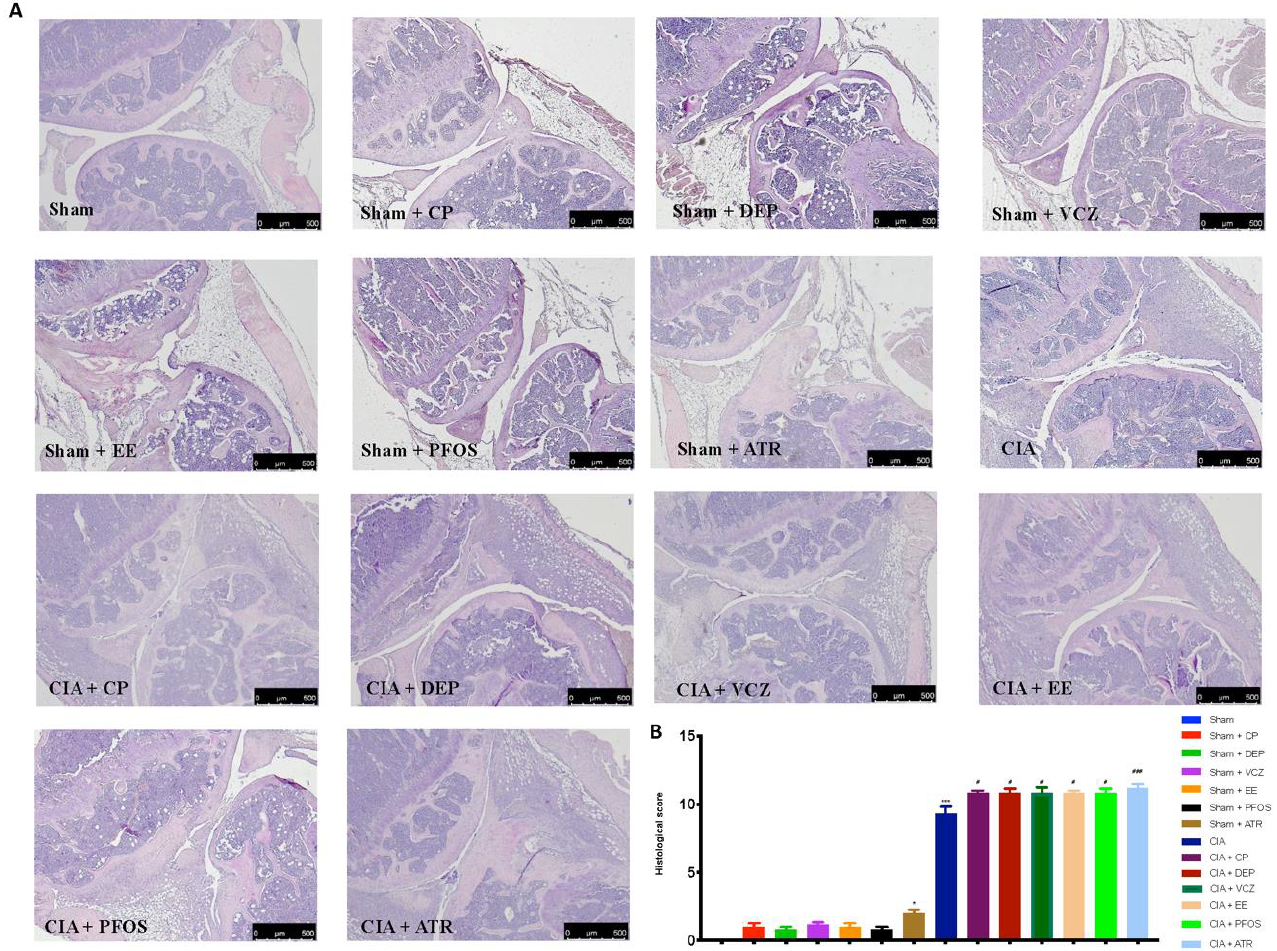
Figure 5. Histological evaluation of knee from all groups ( A ); histological score ( B ). A 2,5× magnification is shown (500-µm scale bar). * p < 0.05 vs. sham; *** p < 0.001 vs. sham; # p < 0.05 vs. CIA; ### p < 0.001 vs. CIA.